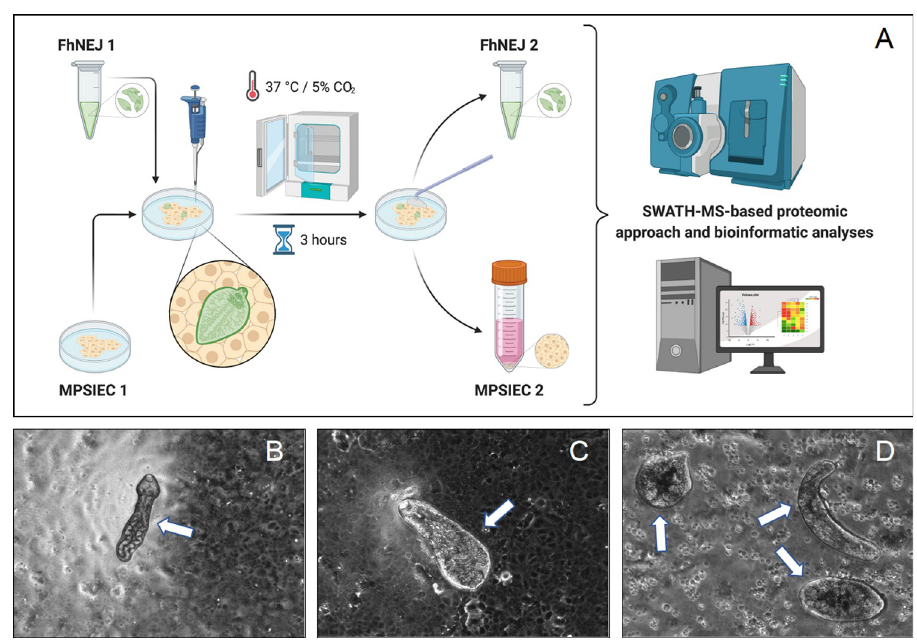
Fig 1. Experimental design of the in vitro interaction model between F . hepatica juveniles (FhNEJ) and mouse intestinal epithelial cells (MPSIEC). (A) Parasitic extracts and host cell lysates were obtained before (FhNEJ 1, MPSIEC 1) and after co-culturing for 3 h (FhNEJ 2, MPSIEC 2) and their proteins analyzed by SWATH-MS. (B, C, D) Representative images of MPSIEC (at the background of each image) stimulated with the FhNEJ (arrows) are shown (optical microscope, 10x). Panel A created with